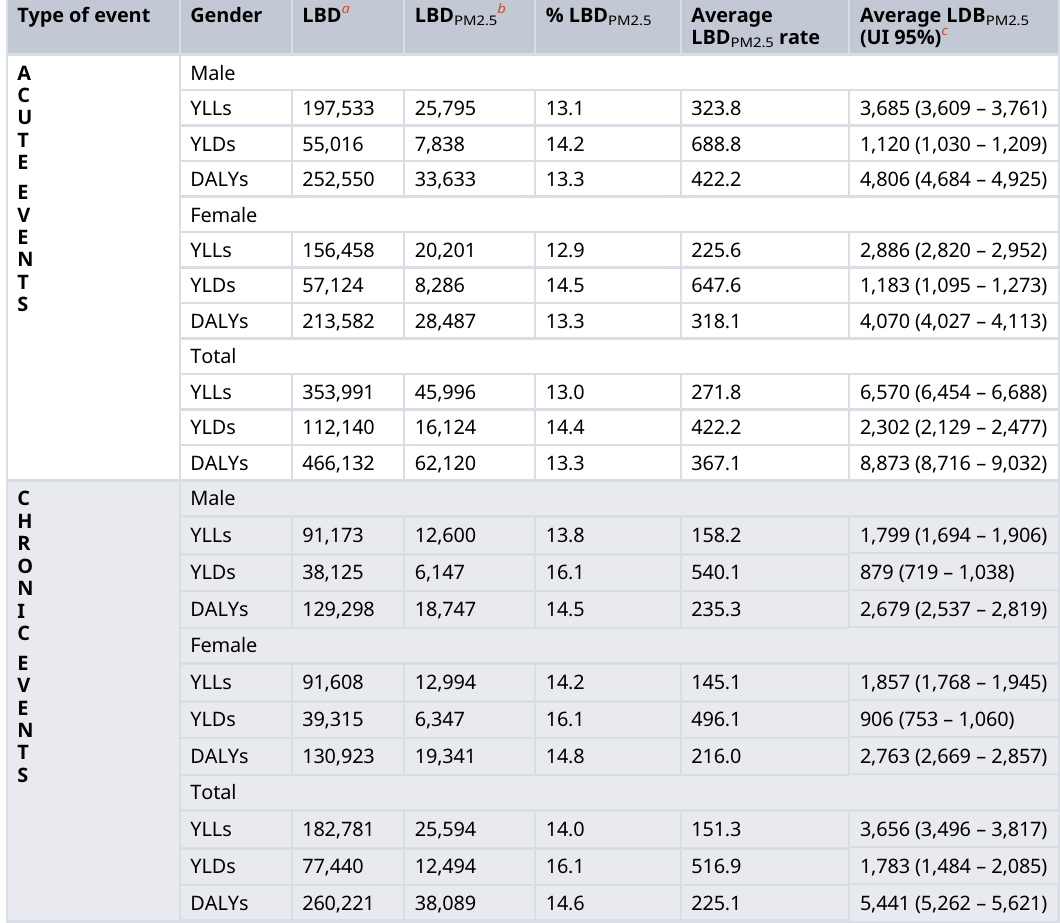
Table 3. Attributable local burden disease to ambient PM 2.5 pollution by type of event and gender,